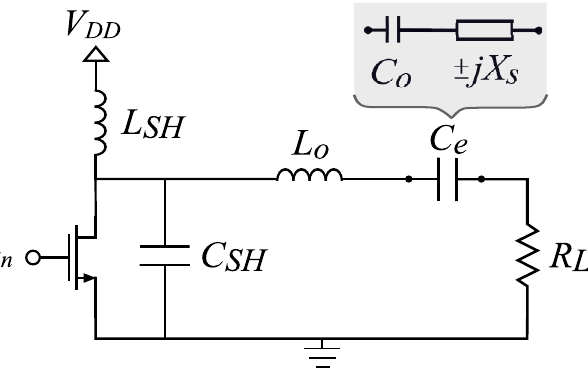
Figure 1. Ideal model of the Class-E Power Amplifier (PA) with finite DC-feed